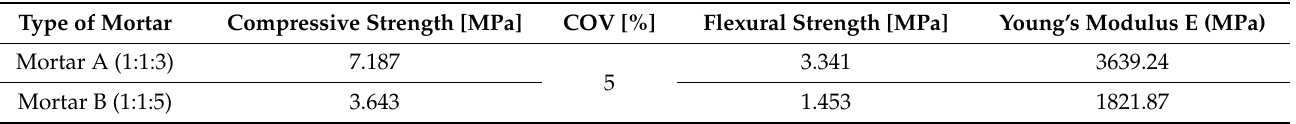
Table 2. Flexural and compressive strength tests for mortars.